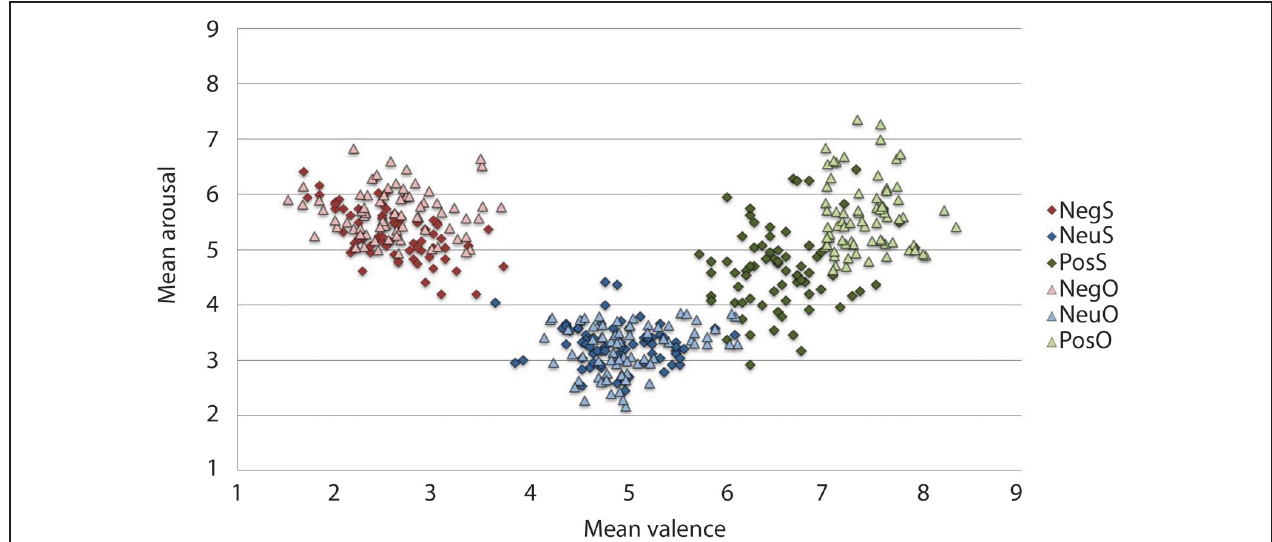
FIGURE 2 | Mean IAPS valence and arousal ratings from the current study sample and the original sample for the 216 pictures selected. On the valence scale, lower numbers denote negative valence, whilst higher numbers reflect positive valence. Similarly, in the arousal scale, high arousal is reflected by higher figures and lower arousal by lower figures. As expected, the current sample rated negative images as high arousing and unpleasant, and neutral images as low in arousal and neither pleasant or